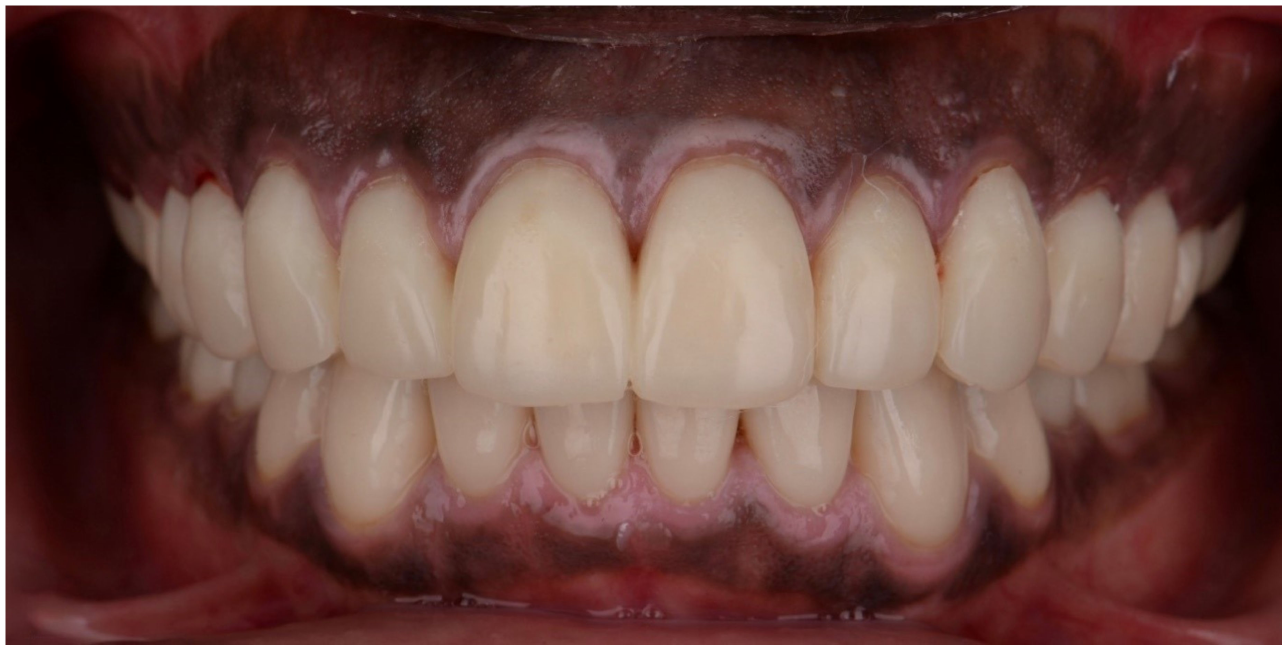
Figure 8. Maxillary and mandibular dentition after provisionalization with PMMA shell. Final impressions were taken with a polyvinyl siloxane material (Aquasil, Dentsply Sirona), and definitive pressed lithium disilicate restorations (eMax, Ivoclar Vivadent)